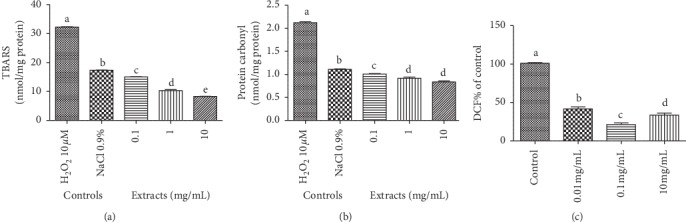
Evaluation of the antioxidant activity of the crude extract of C. nutans leaves by lipoperoxidation assay (TBARS) (a), carbonyl protein levels (b), and chemical deacetylation of DFCH-DA compound (c). Different letters represent statistical differences according to the Tukey test (<0.001).